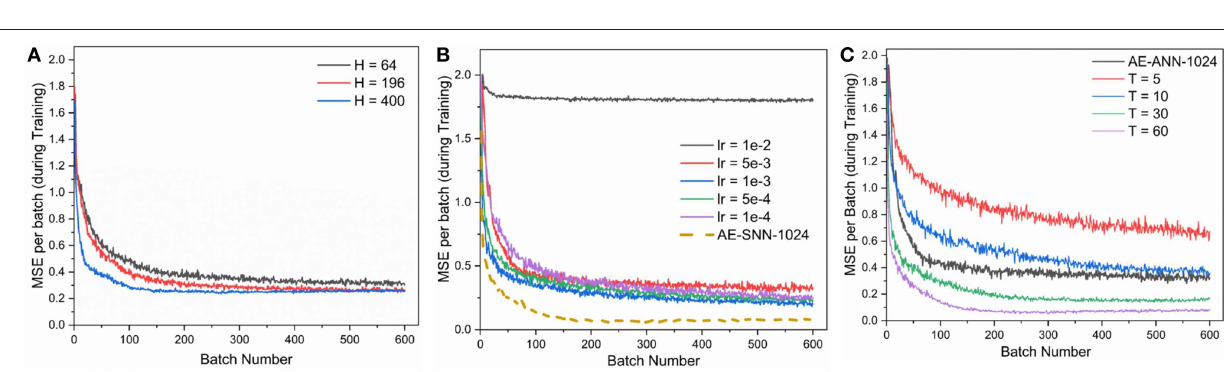
FIGURE 7 | (A) AE-SNN (784 × H × 784) trained on MNIST (training examples = 60,000, batch size = 100) for different hidden layer sizes = 64, 196, 400 (B) AE-ANN [784 × 1,024 × 784] trained on Fashion-MNIST (training examples = 60,000, batch size = 100) with Adam optimization for various learning rates (lr). Baseline: AE-SNN trained with input spike train duration of 60 time steps. (C) AE-SNN [784 × 1,024 × 784] trained on Fashion-MNIST (training examples = 60,000, batch size = 100) for varying input time steps, T = 15, 30, 60. Baseline: AE-ANN trained using Adam with lr =